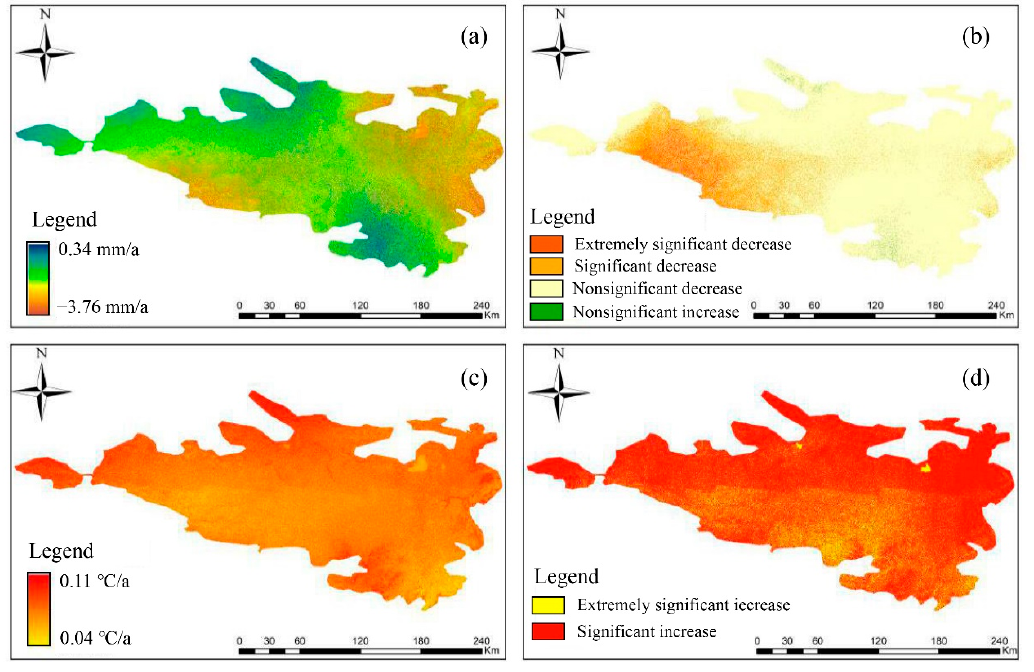
Figure A3. Spatial distribution of annual precipitation and annual mean temperature variation in OSL. ( a ) Variation trend of precipitation; ( b ) Significance of precipitation trend change; ( c ) Variation trend of temperature ( d ) Significance of temperature trend change.